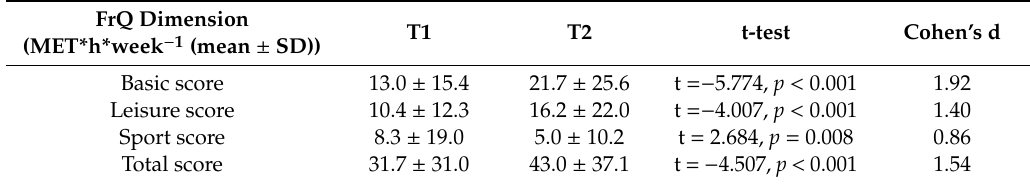
Table 1. FrQ results. Results display MET*h*week − 1 depending on dimensions of FrQ. Time points are